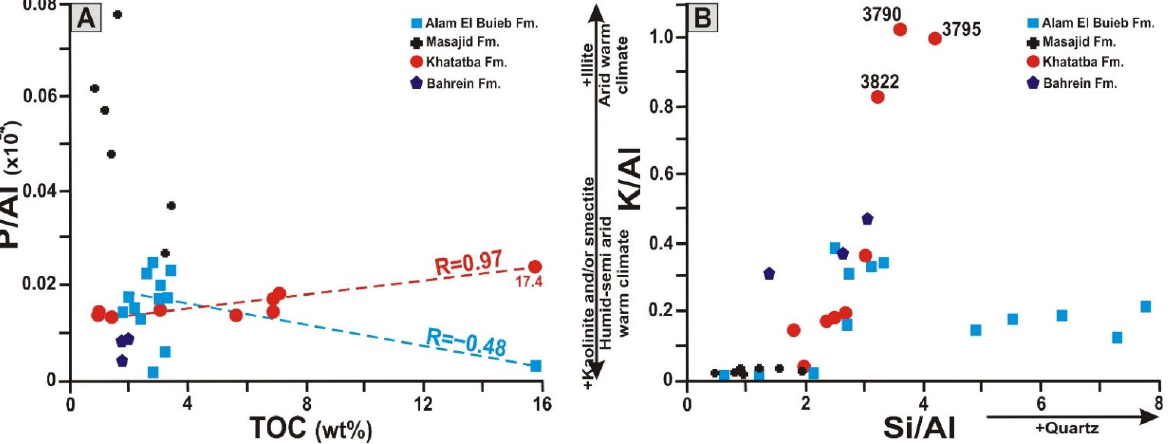
Figure 6. ( A ) Plot of the P/Al ratio versus TOC content. ( B ) Plot of K/Al against Si/Al ratios.